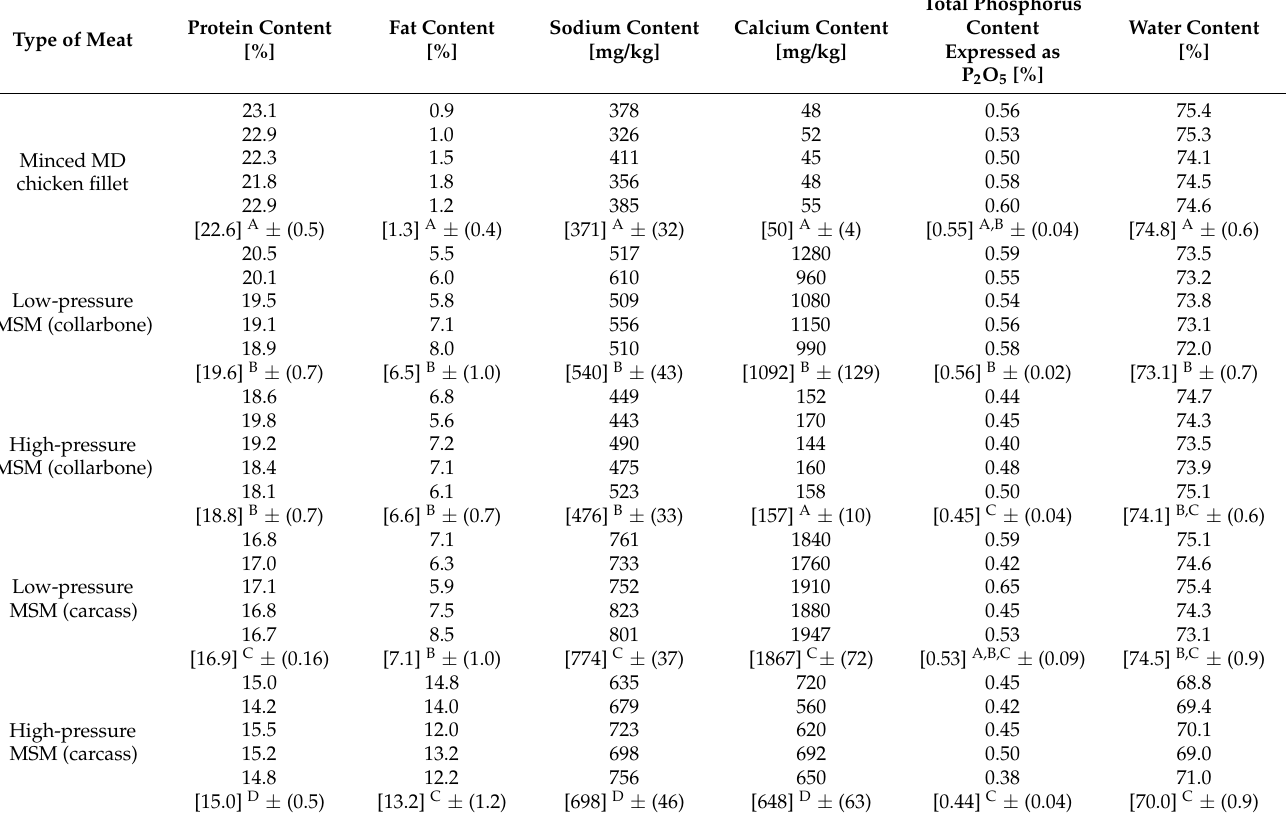
Table 1. Measured chemical composition of the investigated meat samples. Mean values and standard deviations are given in square and round brackets respectively. Mean values in the same column equipped with different superscript letters A, B, C, and D are statistically different ( p <